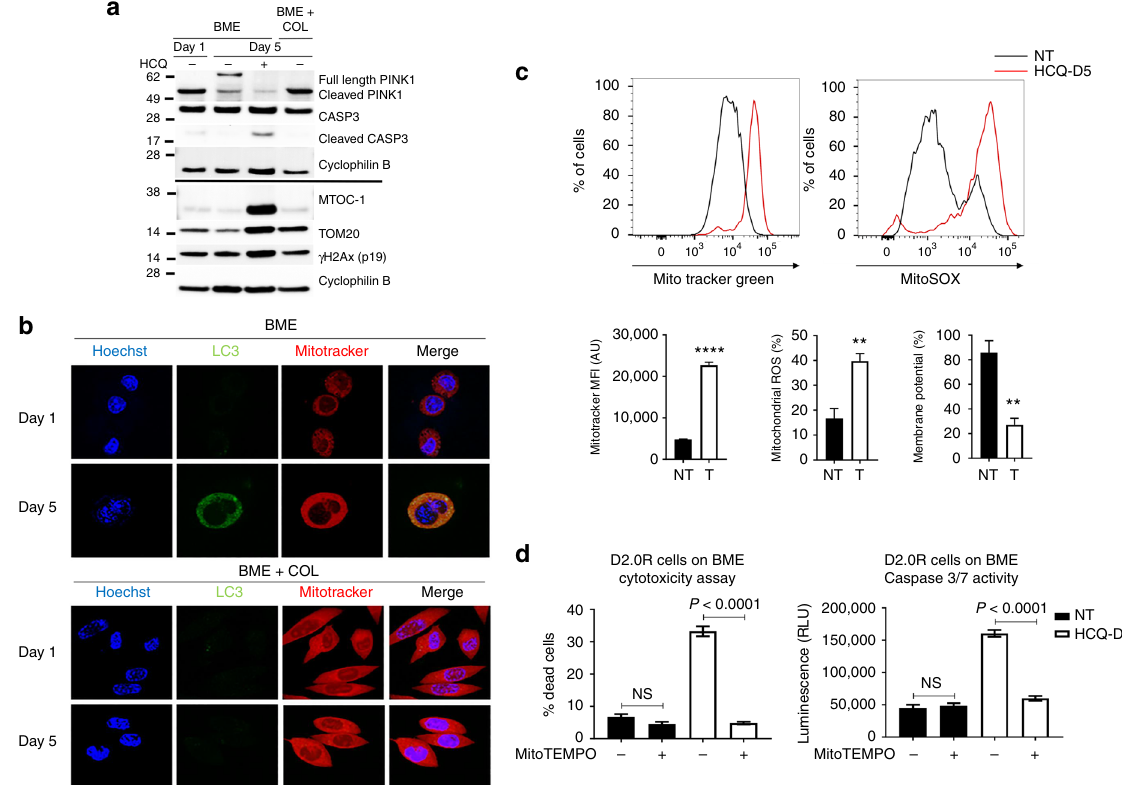
Fig. 7 Autophagy inhibition leads to dysfunctional mitochondria and apoptosis. a Representative western blot of mitophagy markers from D2.0 R cells plated on BME or BME plus COL1 with or without HCQ on days 1 and 5. b Representative images of live D2.0 R cells transfected with the GFP-LC3 reporter and stained with MitoTracker ® Red CMXRos on BME or BME plus COL1 matrices for 5 days. Scale bar is 20 µ m c Mitochondrial (MitoTracker ® Green), mitochondrial reactive oxygen species (ROS; MitoSox ™ ) and mitochondrial membrane potential (TMRM) quanti fi cation in D2.0 R cells on BME or BME plus COL1 matrices with or without HCQ (mean ± s.e.m, n = 60,000 cells from 3 independent experiments. Comparisons by Mann – Whitney U -test,